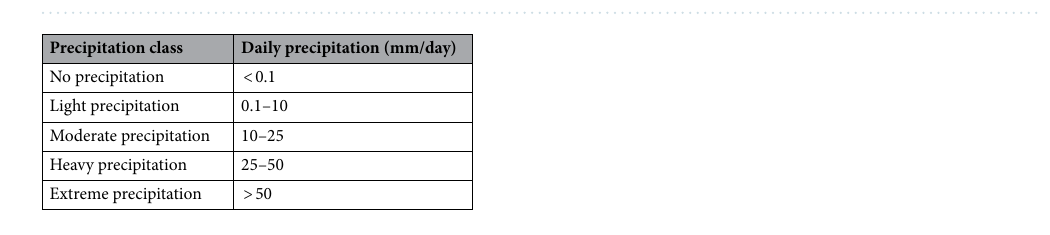
Table 2. C lassification of precipitation based on daily bias-corrected gauge